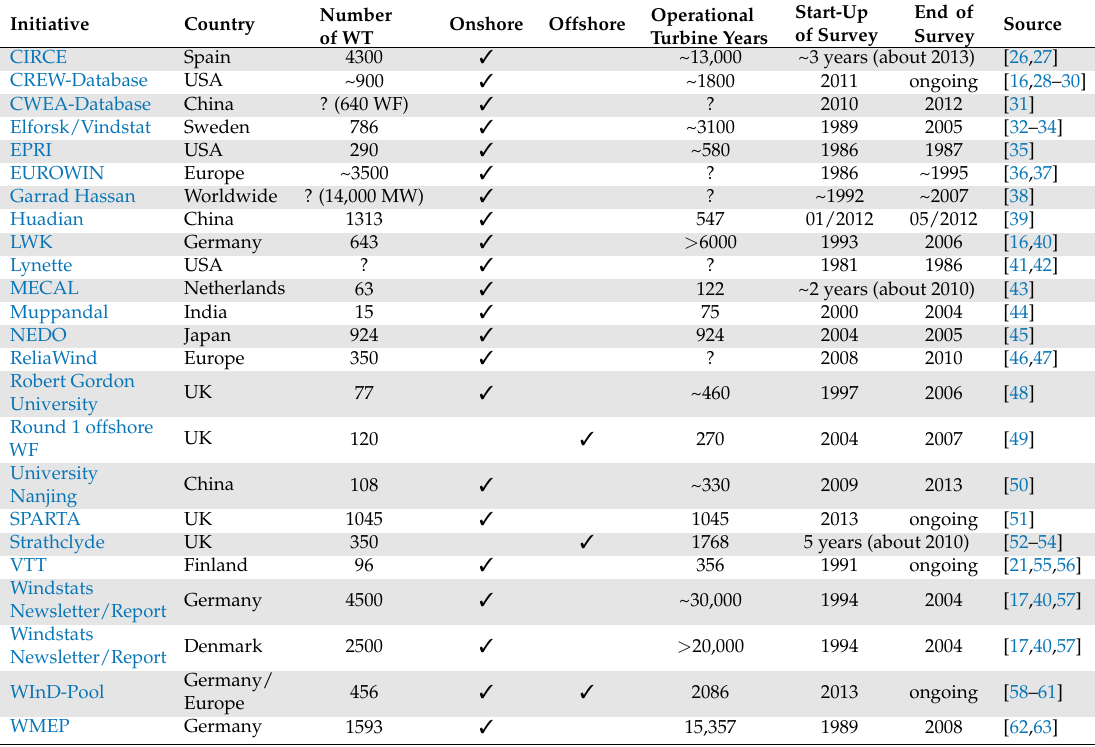
Table 1. Past and ongoing initiatives collecting and analyzing data regarding performance and reliability of wind turbines